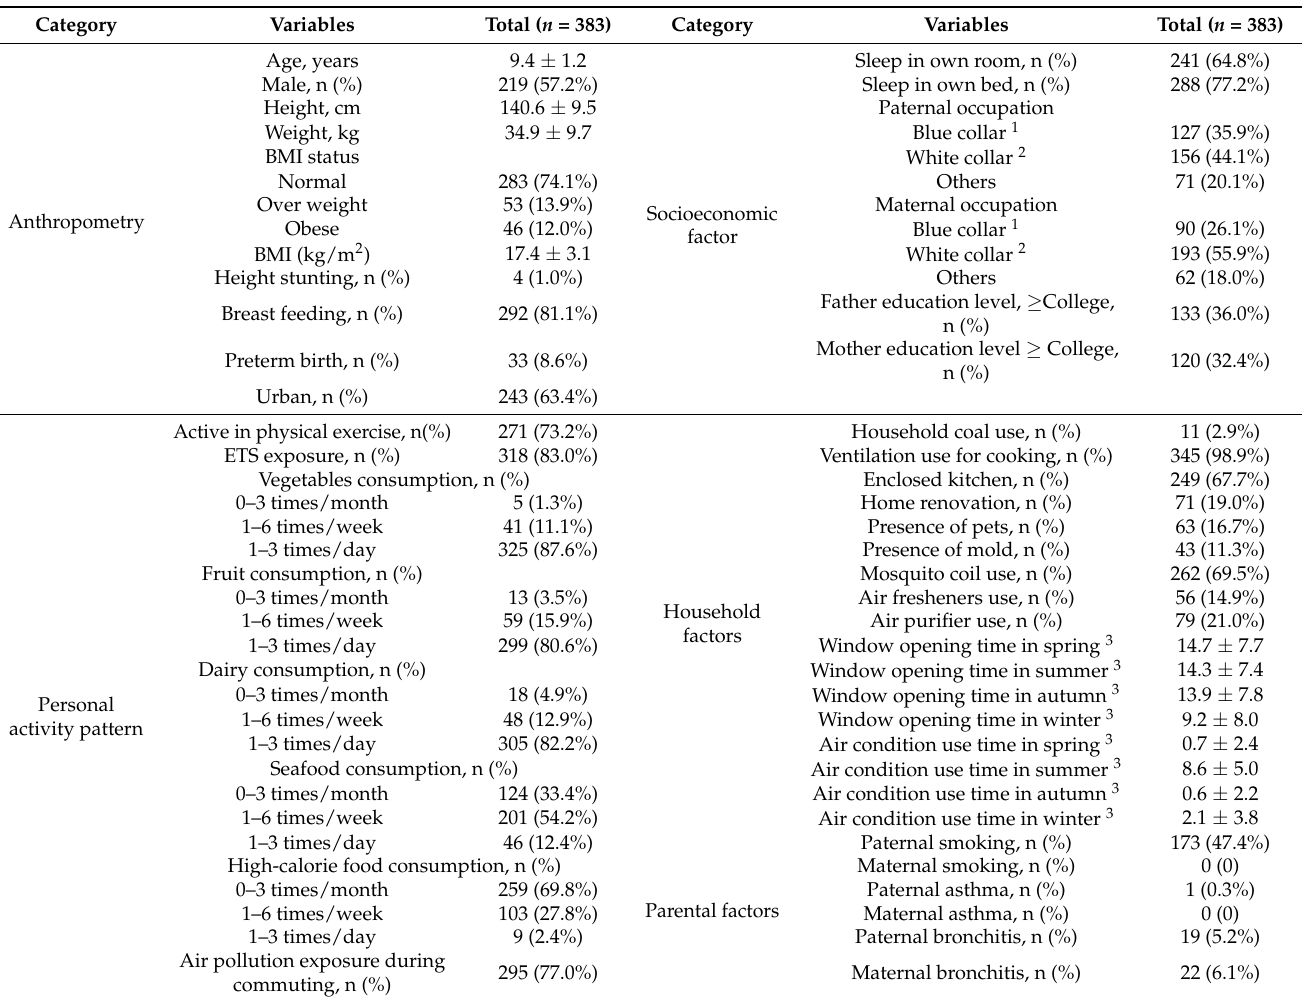
Table 1. Anthropometry, sociodemographic, household, and parental information, and children’s behavior